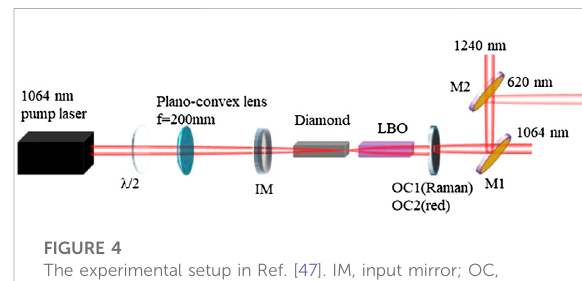
FIGURE 4 The experimental setup in Ref. [47]. IM, input mirror; OC, output coupler; M, mirror. Image originally published in Ref. [47] and reproduced with permission from Springer Nature.